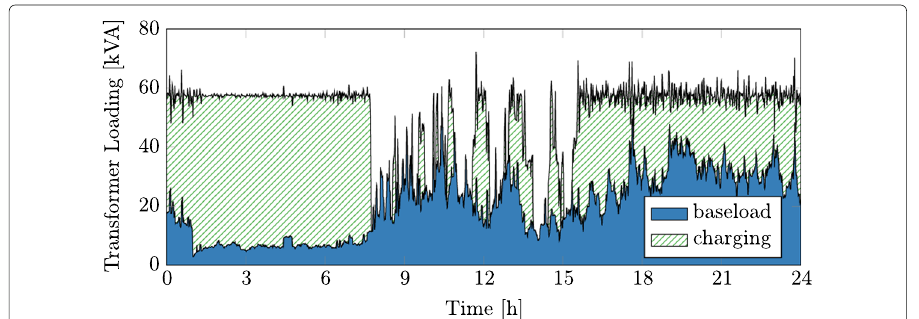
Fig. 10 Loading at the transformer during one day, limited to 100% of the baseline peak load. EV charging with 22 kW using the DWFQ